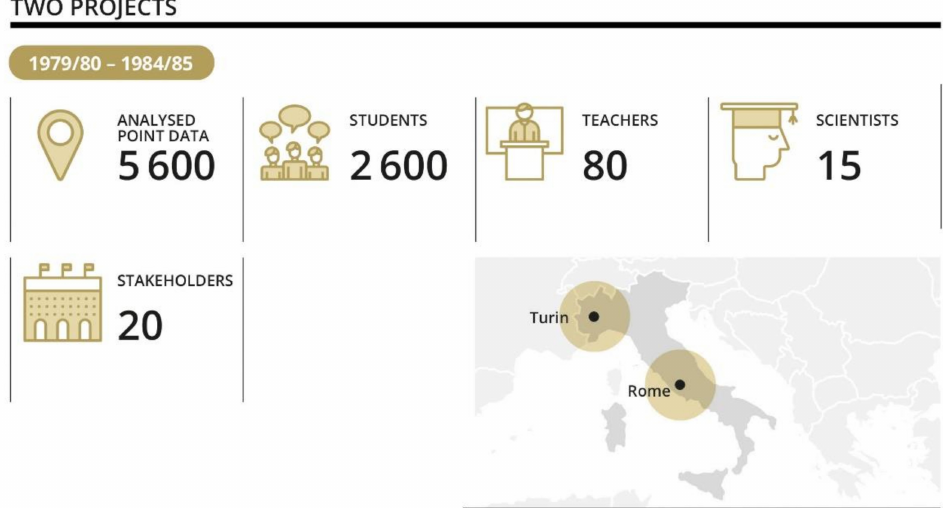
Figure 5. Re-examining a couple of old projects and rediscovering meaningful messages for the current citizen science movement is the goal for this study. Two high school science fair projects, inspired by a science program of citizen science monitoring started in the early 1980s with their classroom teachers and concerned stakeholders. The information was conveyed to a wide audience of students, with the participation of teachers. The most motivated students became “researchers” and provided the basic data to the scientists, who elaborated with interpretations, which were then discussed with students and